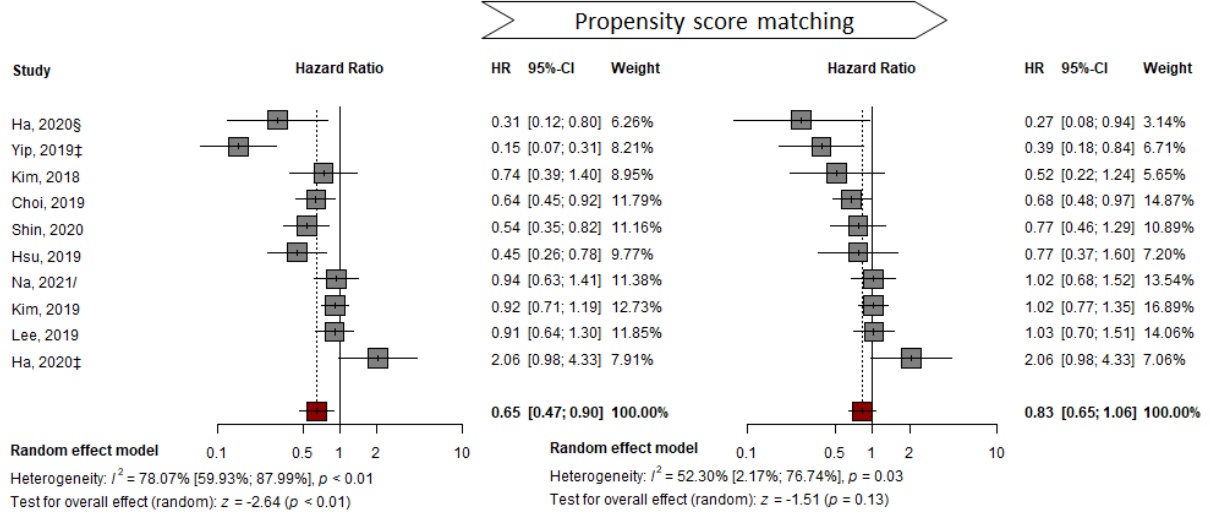
Figure 4. Propensity-score matched HR pooled analysis comparing the effectiveness of TDF vs. ETV